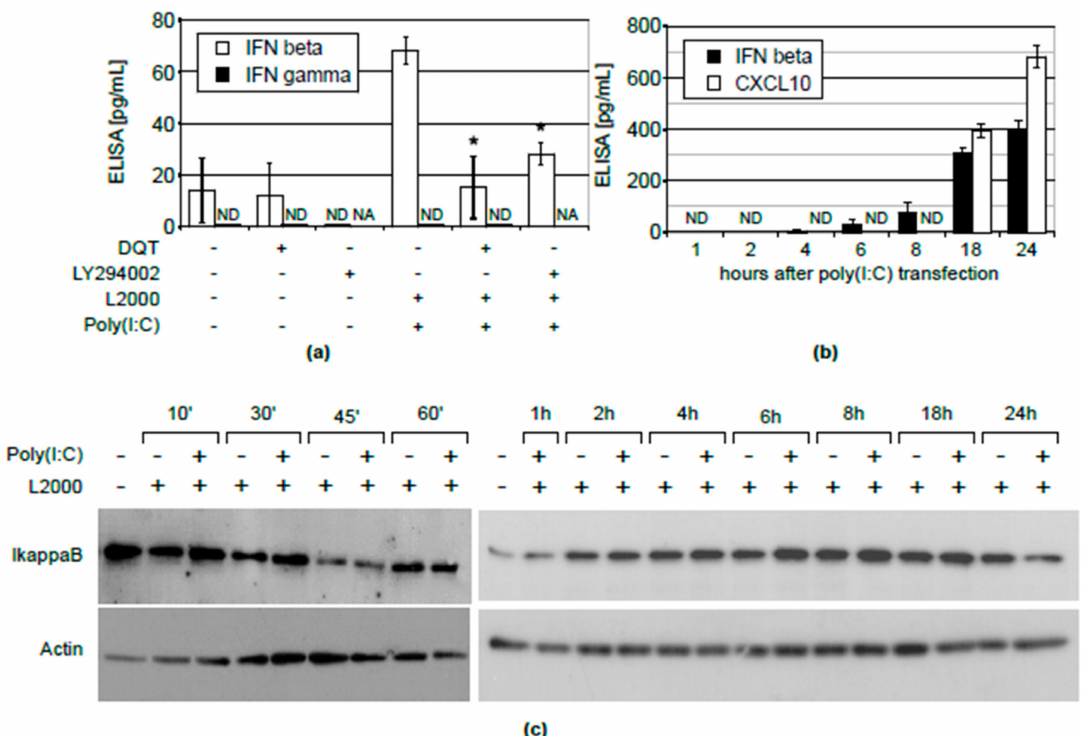
Figure 3. DQT inhibits poly(I:C)-induced CXCL10 synthesis in KERTr cells by inhibiting IFN β , but not IFN γ production; ( a ) levels of IFN β and IFN γ in cell culture media of KERTr cells transfected with 0.2 µ g of poly(I:C) using Lipofectamine2000 (L2000) and/or treated with 5 µ M DQT or 25 µ M of LY29002 for 24 h; mean values and standard deviations are shown; IFN γ was undetectable (ND); non-assessed probes are marked as NA; ( b ) kinetics of IFN β and CXCL10 induction upon transfection with poly(I:C); mean values and standard deviations of two independent experiments are shown; ( c ) Western blot of I κ B from KERTr cells transfected with 0.2 µ g of poly(I:C) using Lipofectamine2000 (L2000) alone or treated with 5 µ M DQT for the indicated time; representative blots are